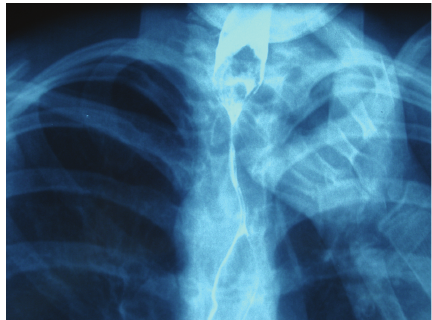
Figure 2: A radiolucent FB (a peach seed) within first esophageal